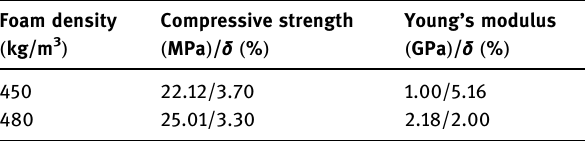
Table 2: Mechanical properties of syntactic